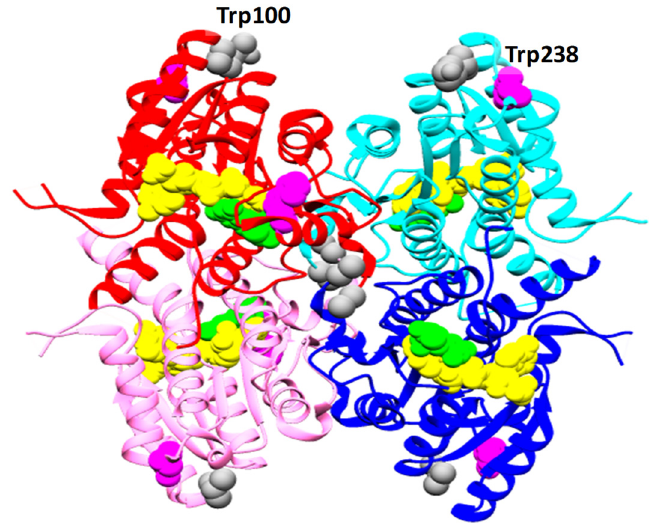
Figure 1. Quaternary structure of Lm PTR1 (PDB ID: 1E92). The four monomers are shown in red, pink, blue and pale blue ribbons. Tryptophans 100 and 238 are shown in, respectively, grey and fuchsia for all monomers. The NADP cofactor and the dihydrobiopterin substrate are reported in the catalytic pockets with atoms displayed as yellow and green spheres.